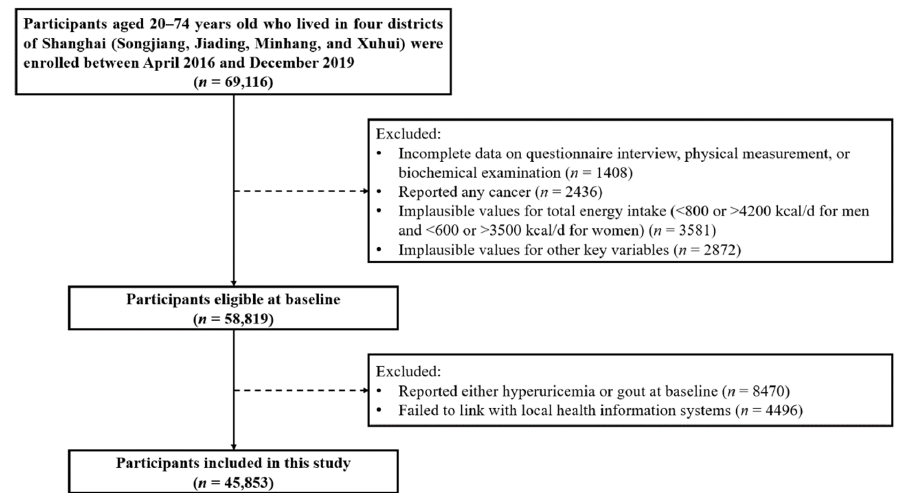
Figure 1. Flowchart of the study participants’